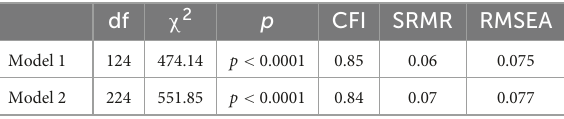
TABLE 2 Goodness of fit statistics for the mental health and minority stress ARCL